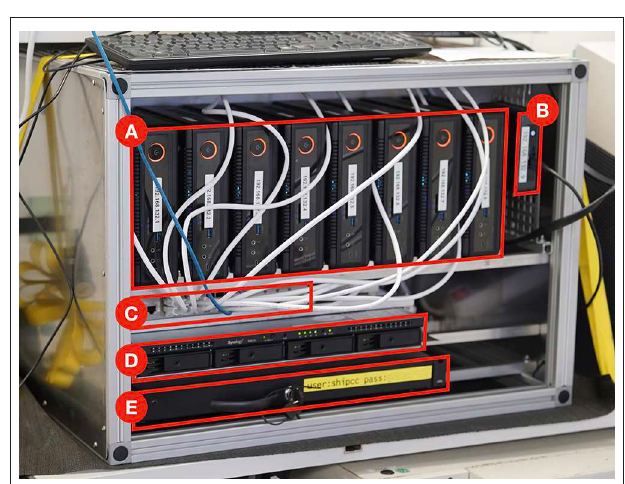
FIGURE 2 | Setup of the one SHiPCC unit as deployed on cruise POS526 comprising eight compute nodes (A) , one job scheduling control node (B) , a Gigabit Ethernet switch (C) , a four bay network attached storage of 24TB (D) and a drawer for further equipment like portable hard disks (E) . The dimensions of one unit are 72 × 51 × 52 cm (W × H ×